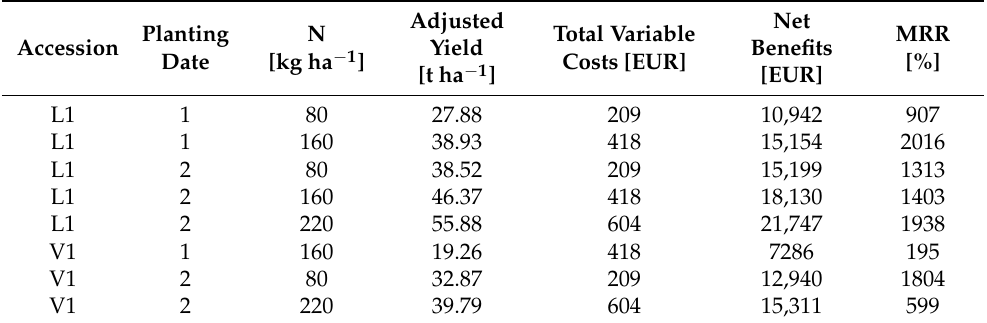
Table 7. Marginal rate of return (MRR) analysis of the two accessions expressed as an average of the two agricultural